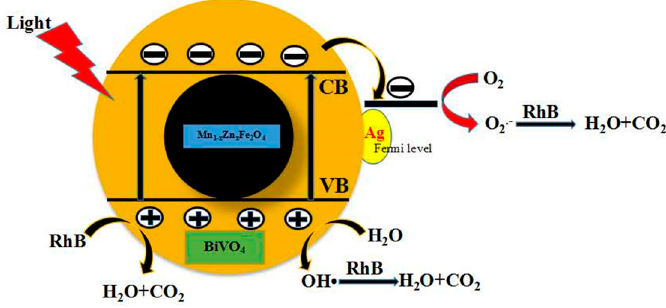
Figure 10. Photocatalytic mechanism scheme of Ag/BiVO 4 /Mn 1 − x Zn x Fe 2 O 4 .